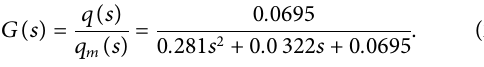
Frontiers in Robotics and AI |